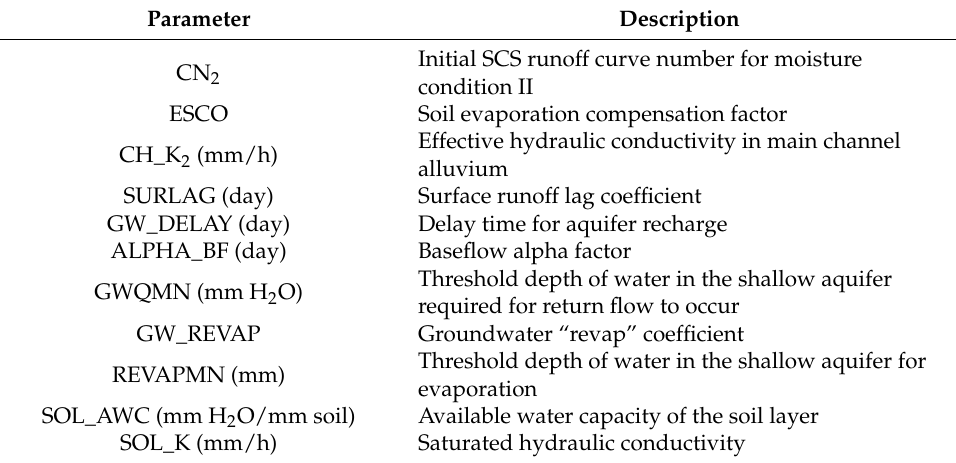
Table 2. Descriptions of the major parameters for the SWAT model used in this study for the Songhua River